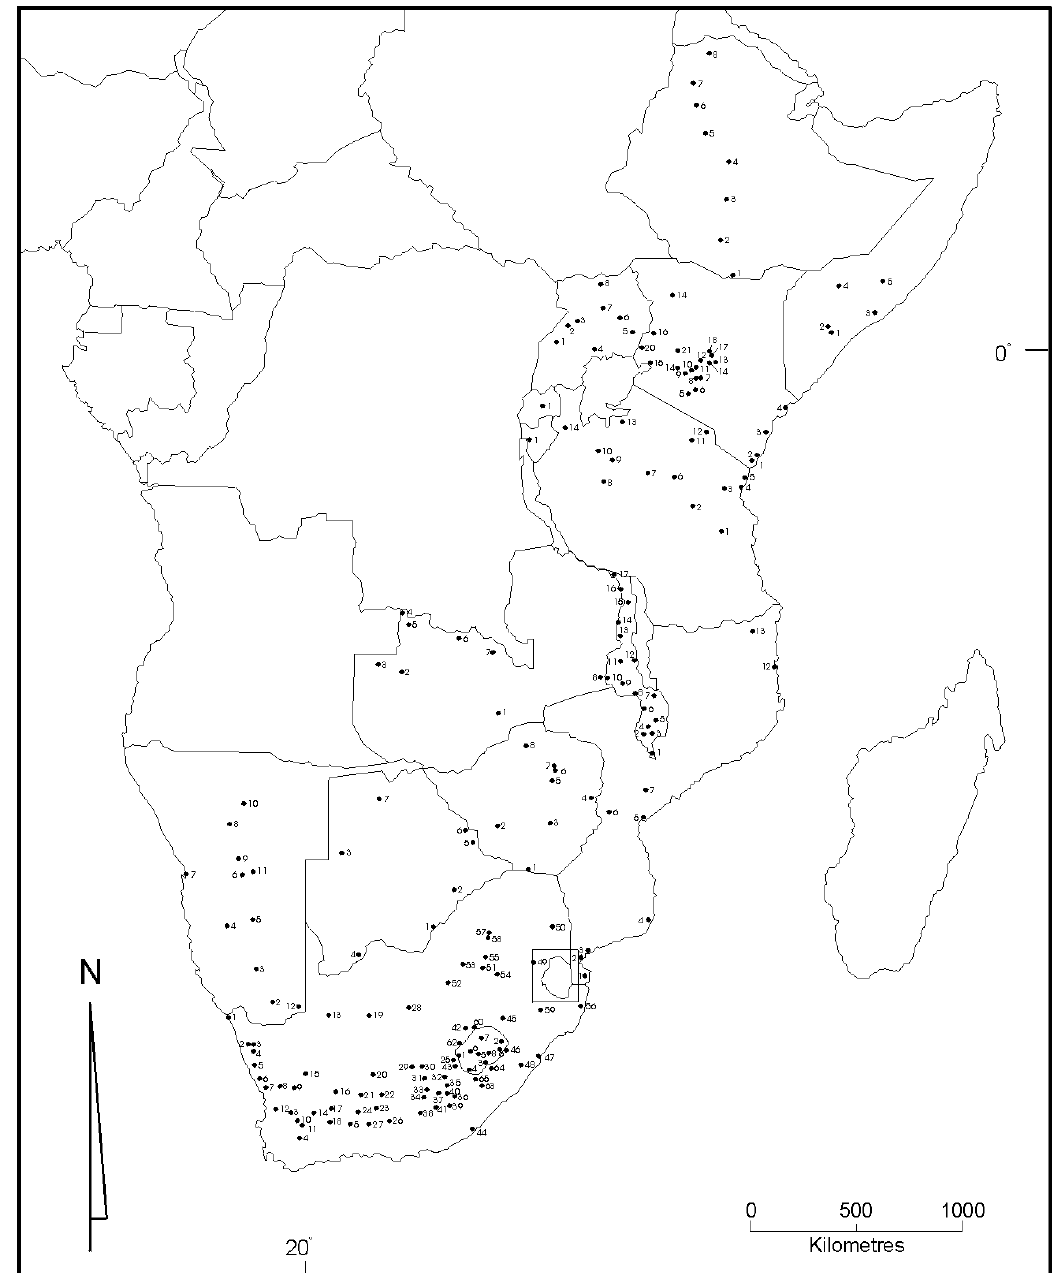
Figure 1 - Map of eastern Africa indicating the localities at which worker honeybees were collected for analysis in our study. Note that for each country the numbering system for localities always begins with “1” to avoid overlapping. Map numbers for each country correspond to the geographical and biological information in Table